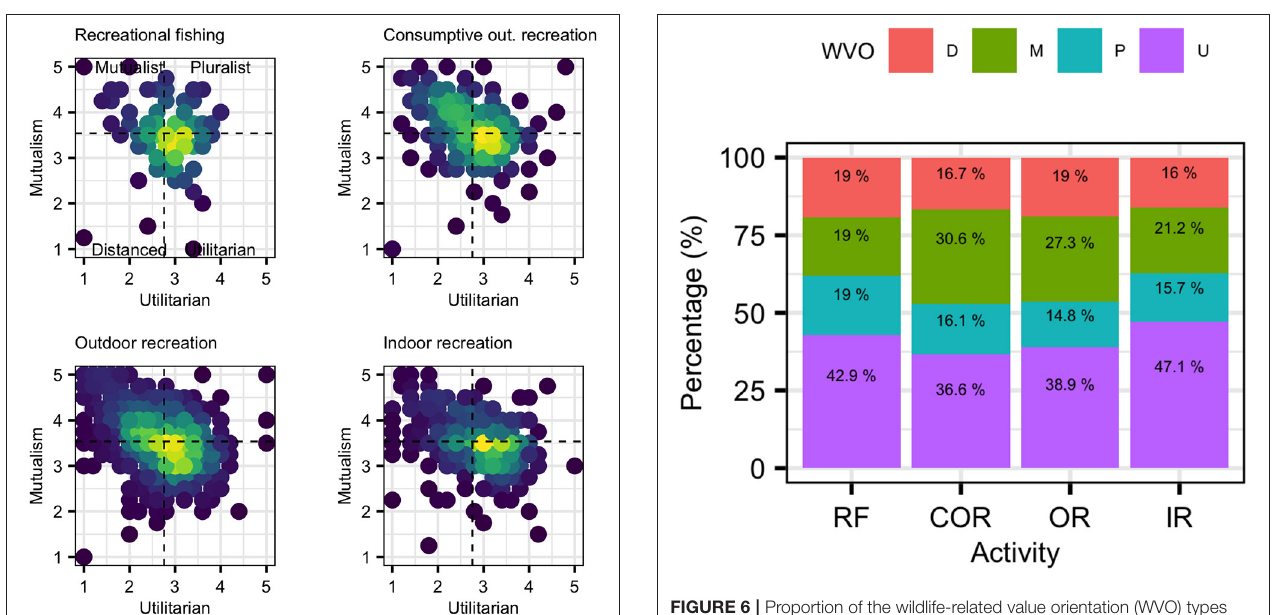
FIGURE 6 | Proportion of the wildlife-related value orientation (WVO) types (mutualists, M; utilitarians, U; pluralists, P; and distanced, D) among the different IR and OR profiles. No significant differences were found among the four IR and OR